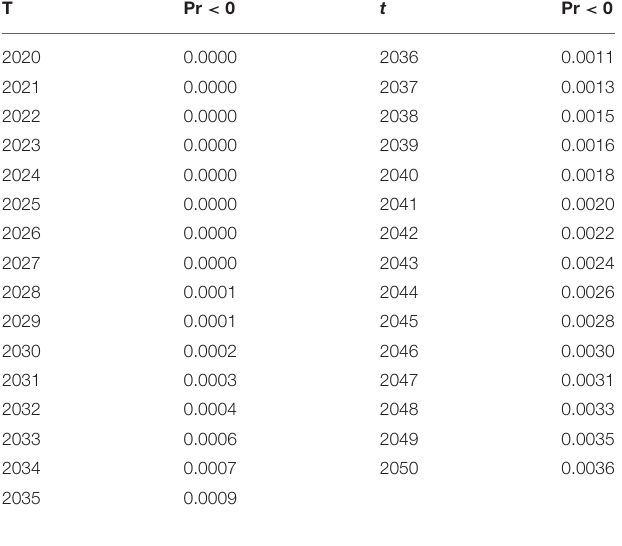
TABLE 3 | Probabilities of negative interest rates under the Vasicek model.